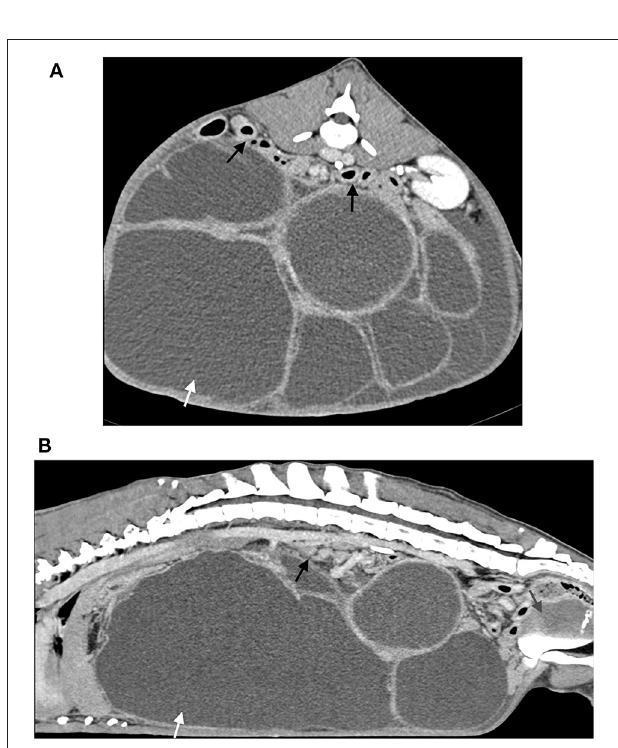
FIGURE 4 | Post-contrast CT acquisition of the abdomen of D7. (A) Transverse image, soft tissue window, at the level of the left kidney (B) Sagittal multiplanar reconstruction image, soft tissue window. A large amount of peritoneal fluid (white arrow) loculated by multiple hyperattenuating septations and dorsal gathering of the intestines is present (black arrows). Note also the mass effect of the fluid filled cavities and the secondary caudal displacement of the urinary bladder (gray